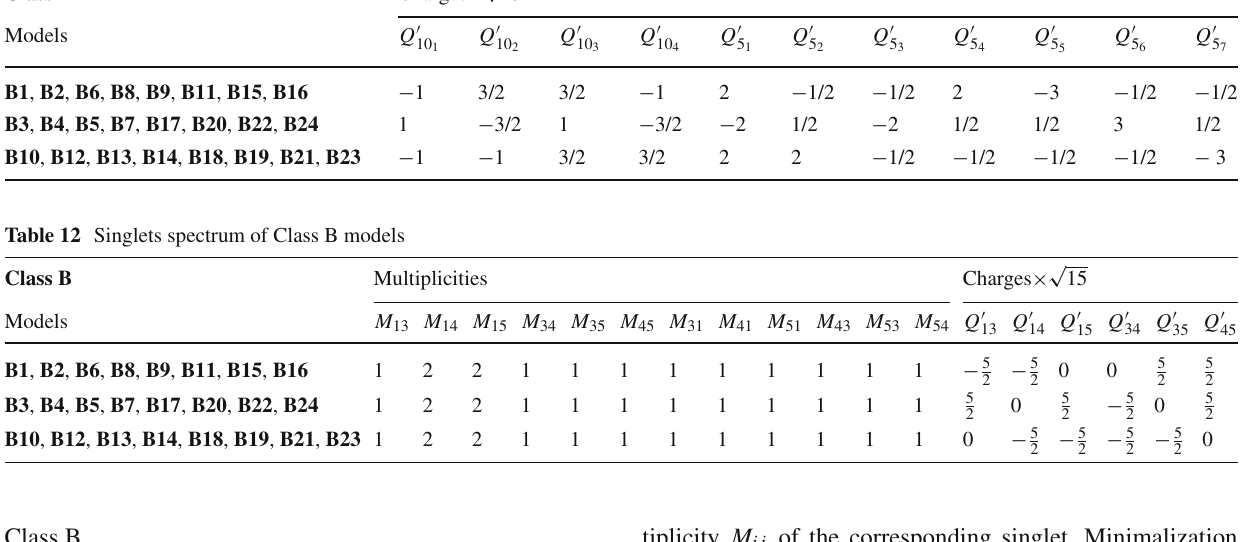
Table 11 U ( 1 ) (cid:2) charges of Class B models Class B